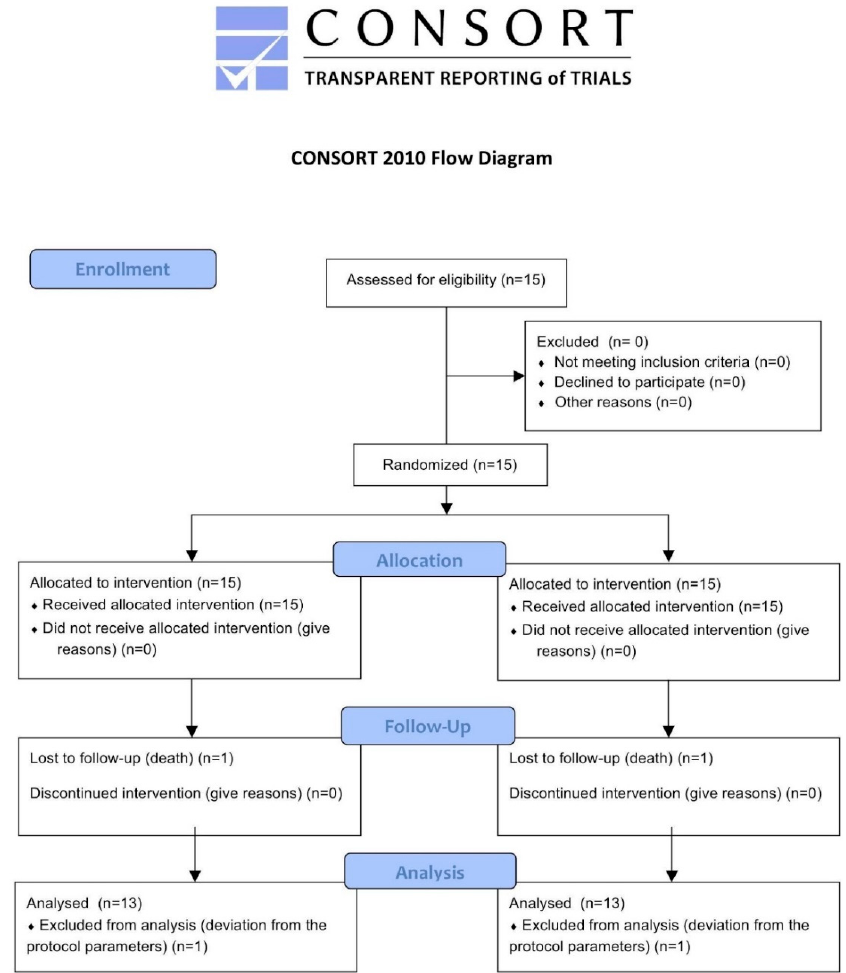
Figure 1. CONSORT 2010 Flow Diagram.